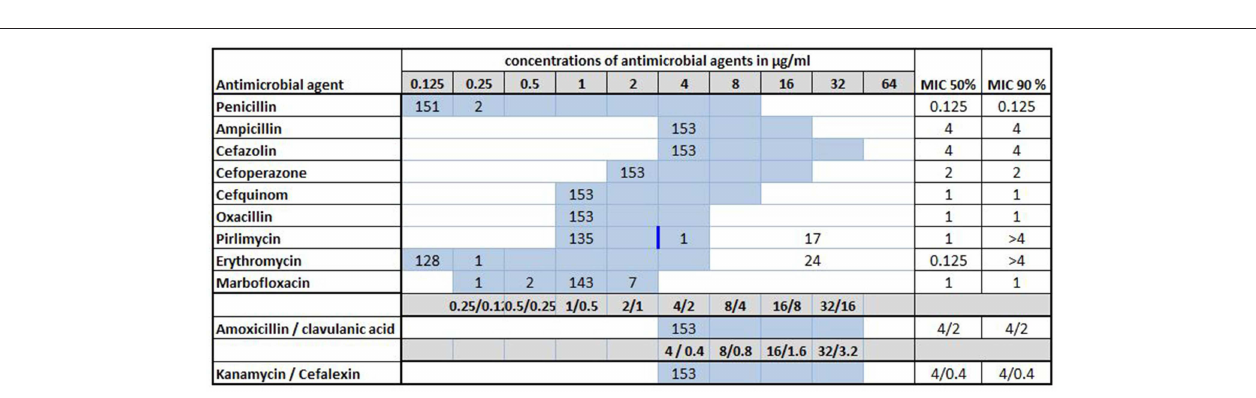
S. uberis mastitis. Erythromycin was tested as a representative